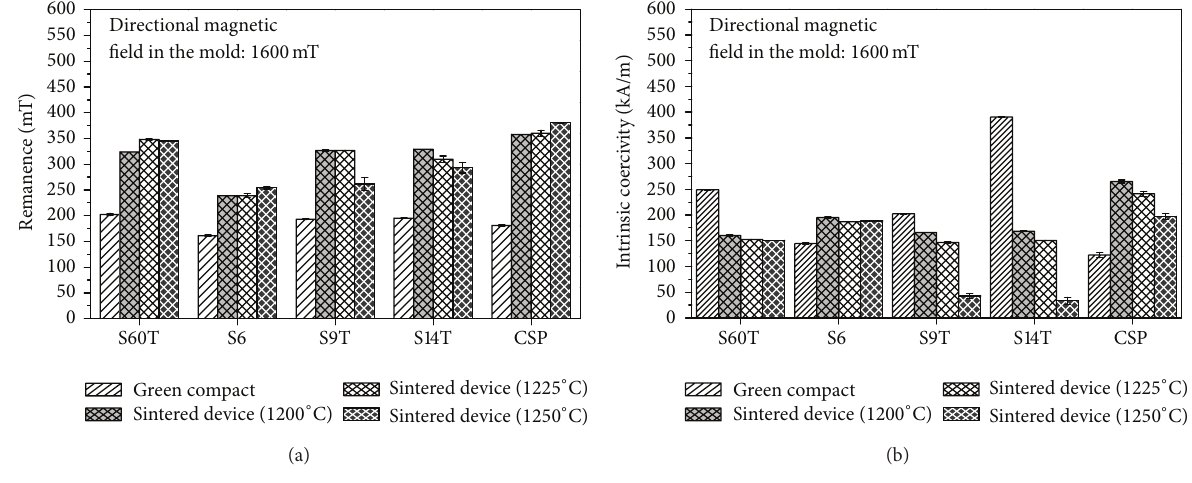
Figure 4: Magnetic properties of green compacts and sintered devices.